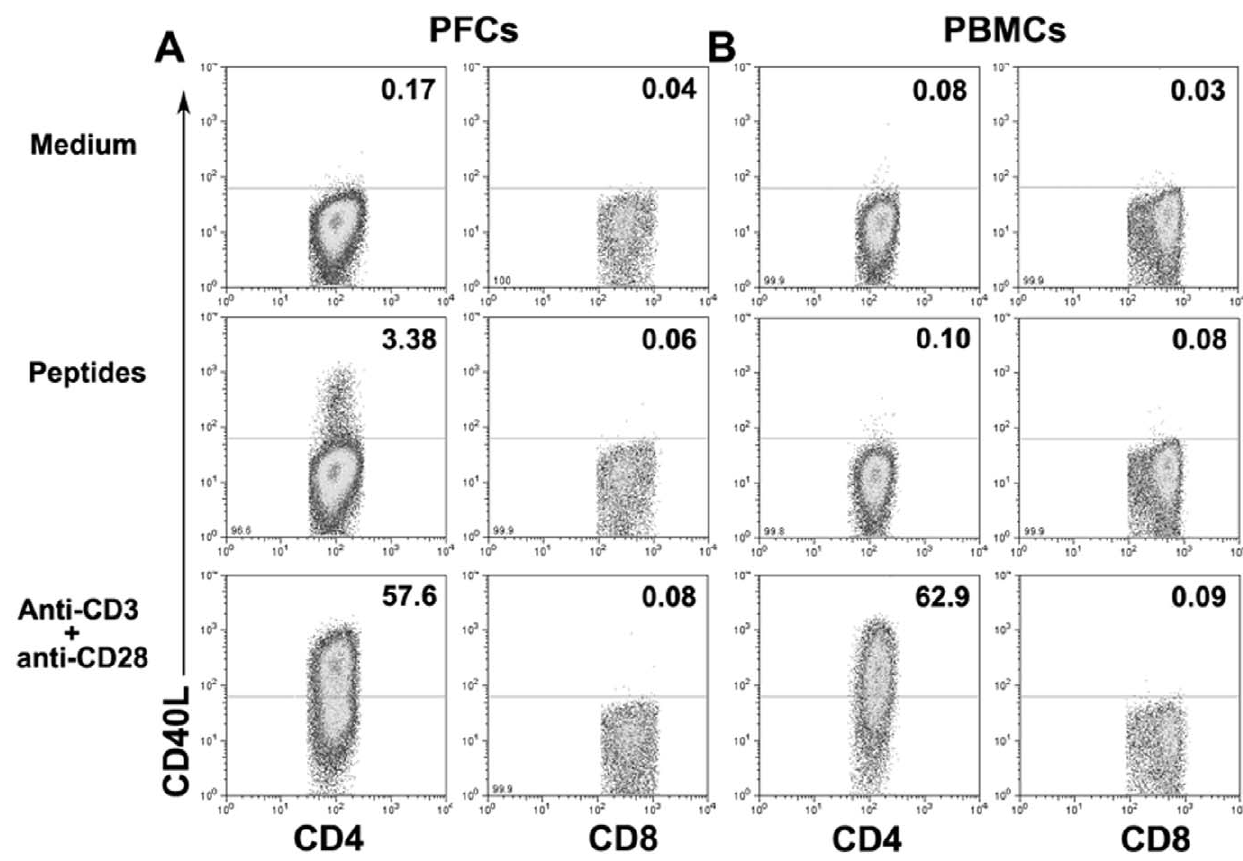
Figure 1. M.tuberculosis (MTB)-specific expression of CD40L on CD4 + and CD8 + T cells from pleural fluid cells (PFCs) of tuberculous pleurisy (TBP) and PBMCs from healthy individuals. PFCs from TBP and PBMCs from healthy donors were incubated for eight hours in the presence of medium alone, ESAT-6/CFP-10 peptides with anti-CD28 plus anti-CD49d or anti-CD3 plus anti-CD28 monoclonal antibodies (mAbs).(A) Expression of CD40L on CD4 + and CD8 + T cells in PFCs from TBP and (B) PBMCs from healthy donors were detected by FACS. Data shown are representative of five independent experiments.